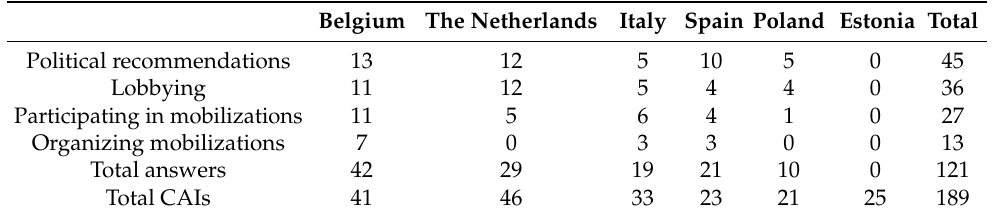
Table 12. Civil Society Mobilization.